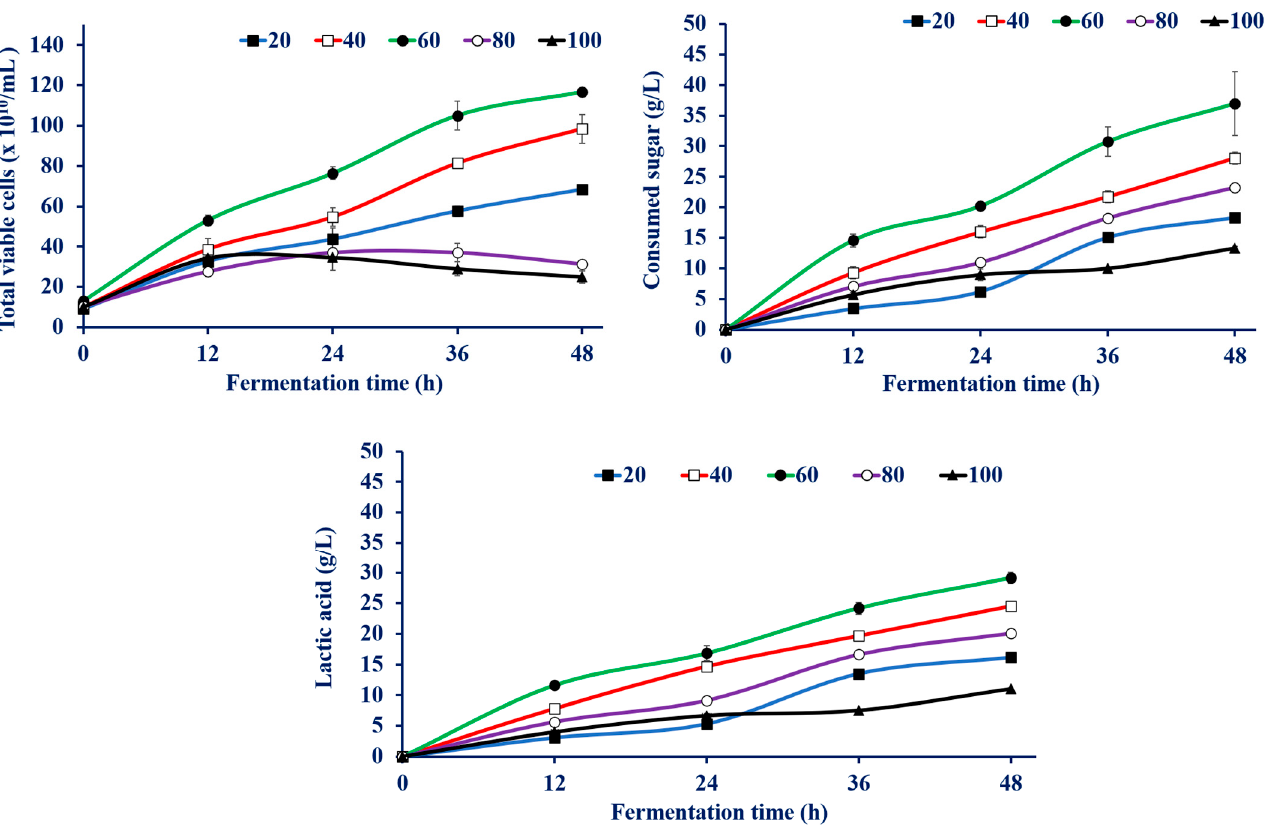
Figure 3. Effect of different concentrations of CSW on the fermentation parameters for lactic acid production by E. faecium WH51-1. The standard deviation is less than the size of symbols if no error bars are seen.